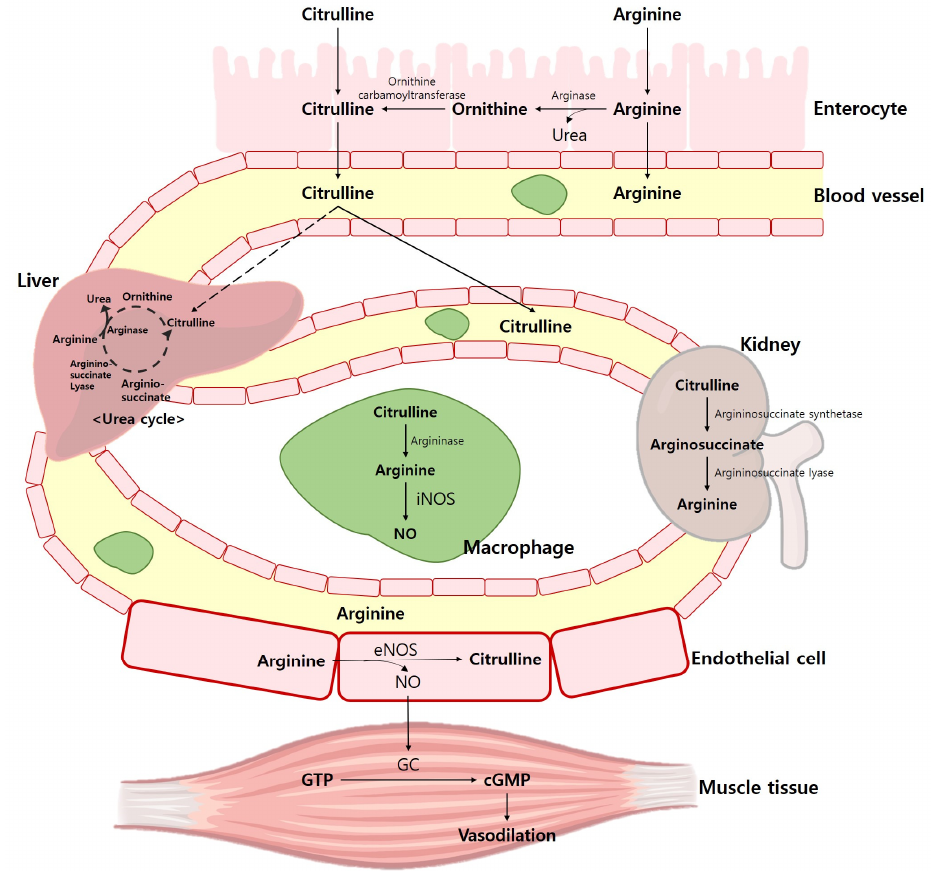
Figure 1. NOS through the Arg and Cit pathway. iNOS, cytokine-induced nitric oxide synthase; eNOS, endothelial nitric oxide synthase; NO, nitric oxide; GC, guanylate cyclase; GTP, guanosine triphosphate; cGMP, cyclic guanosine monophosphate.